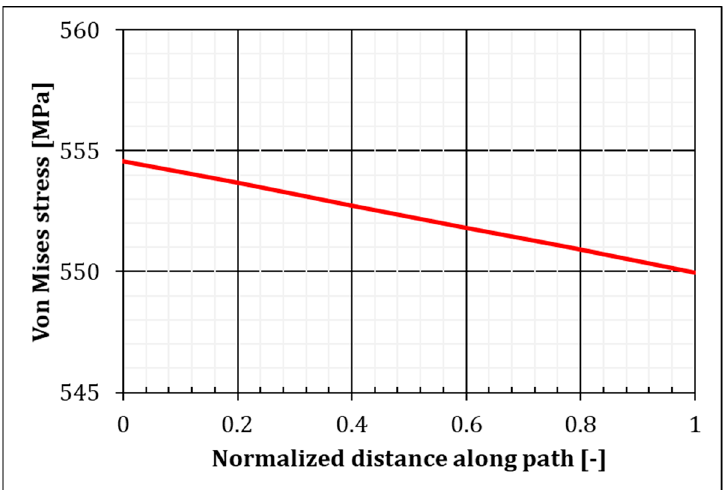
Figure 16. Distribution of von Misses stress in the radial direction along the thickness in the SM1.